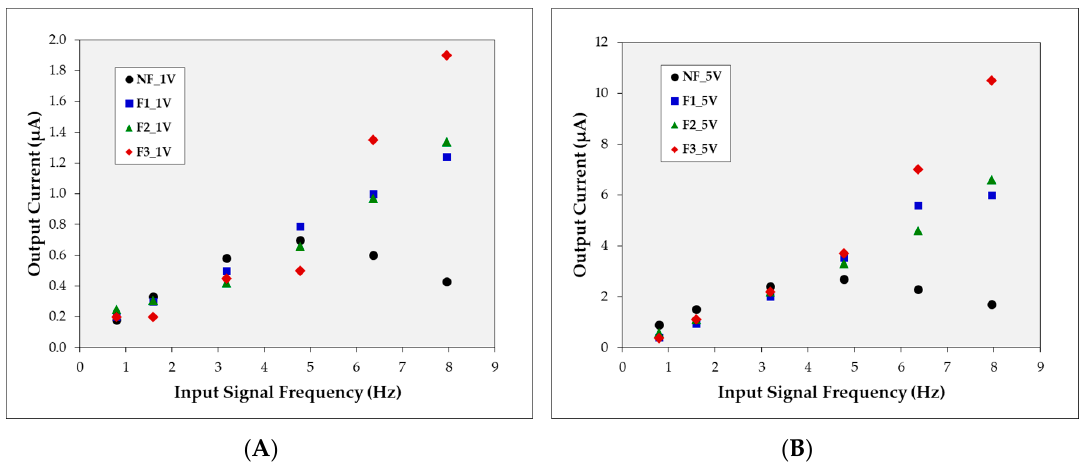
Figure 17. Output current corresponding to input signal frequency when input signal voltage is ( A ) 1 V, ( B ) 5 V.